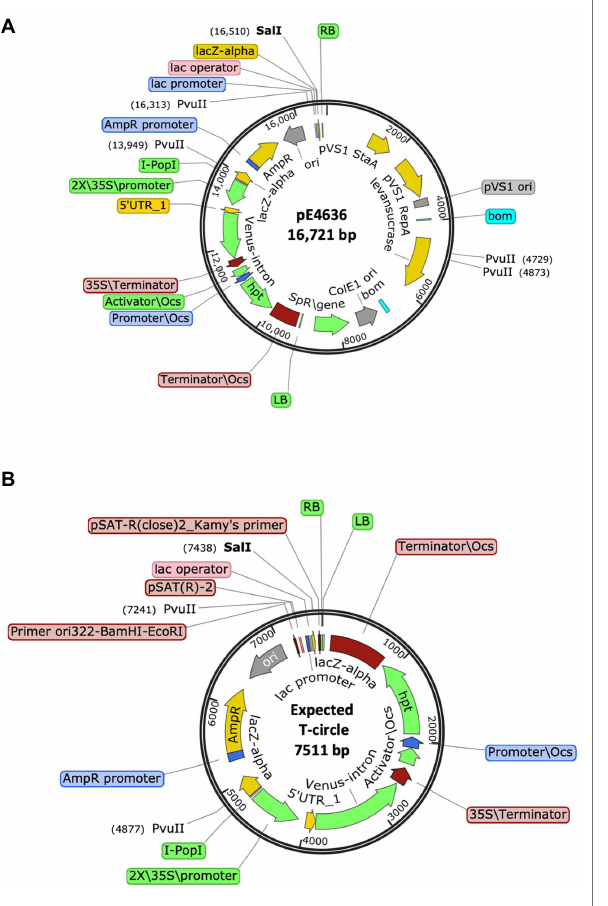
FIGURE 4 | Schematic representation of (A) The T-DNA binary vector pE4636, and (B) The expected T-circle formed from this plasmid by joining of the T-DNA right and left borders (RB and LB,